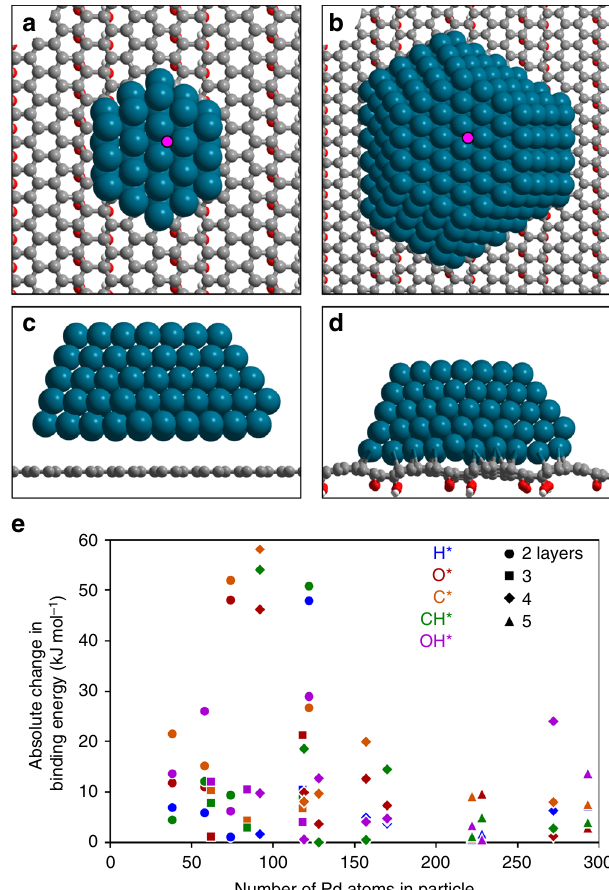
Fig. 6 Theoretical calculations for Pd/C. a Pd 38 and b Pd 293 clusters bound to a functionalized graphene support; pink dot shows binding location of probe adsorbates. c Side-view of Pd 293 cluster above graphene. d Side-view of Pd 293 cluster bound to functionalized graphene support. e Absolute differences in binding energies of H* ( blue ), O* ( red ), C* ( orange ), CH* ( green ), and OH* ( purple ) on sites shown in pink in parts a , b on Pd particles ranging from 38 to 293 atoms and having 2 (circle), 3(square), 4(diamond) and 5(triangle) metal